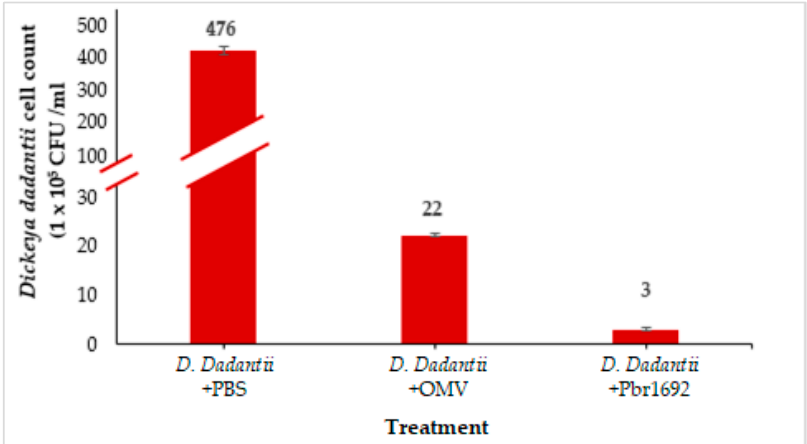
Figure 8. Antimicrobial activity of OMVs. The graph shows D. dadantii cells cocultured with PBS as a negative control and its growth inhibition in the presence of Pbr1692 OMVs and Pbr1692 cells. The results show the means of two independent experiments. Error bars represent the standard deviations from the data. Differences between the effect of the PBS-negative control with Pbr1692 cells and OMVs on D. dadantii was determined to be statistically significant with p < 0.01 in the analysis of variance.